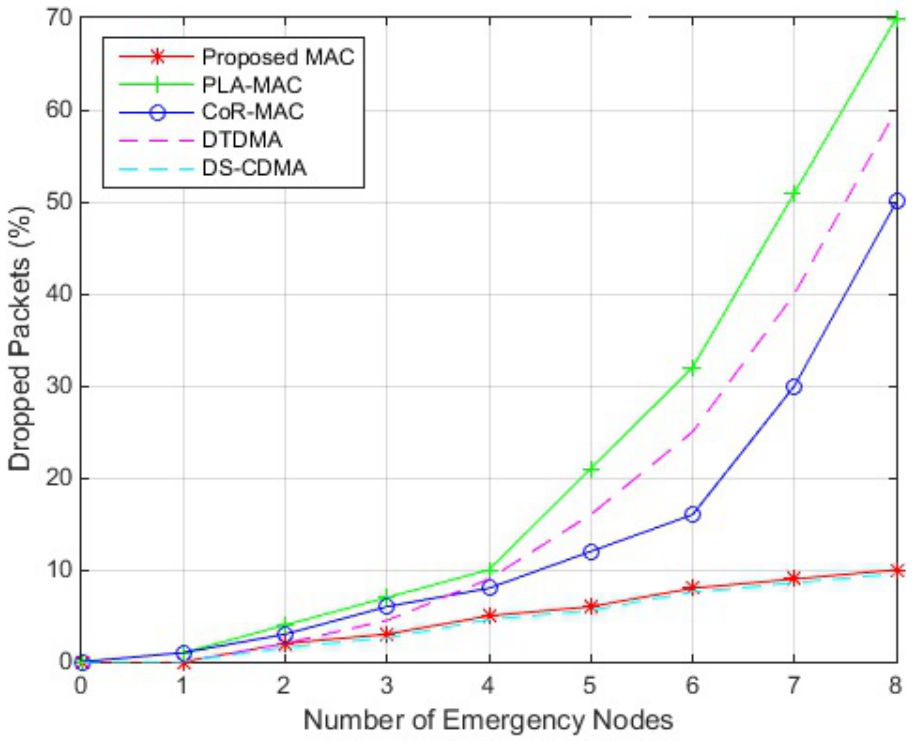
Figure 5. Packet Drop Performance of MAC